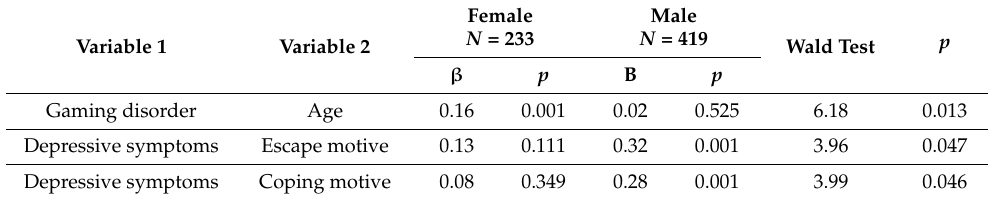
Table 5. Pairwise paths comparisons between female and male